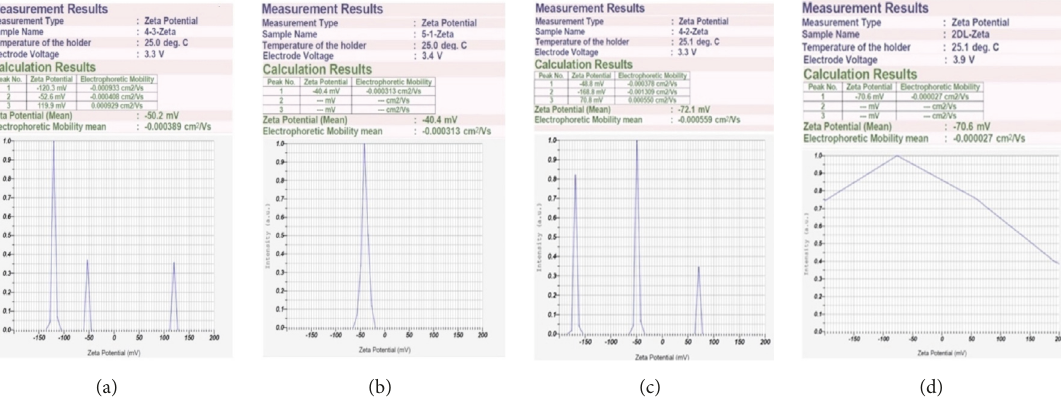
Figure 7: Zeta potential variation of nanofluids. (a) Lubricants with 10-hour ball-milled MWCNTs immediately after preparation, (b) lubricant with 10-hour ball-milled MWCNTs after 60 days, (c) lubricant with 20-hour ball-milled MWCNTs immediately after preparation, (d) lubricant with 20-hour ball-milled MWCNTs after 60